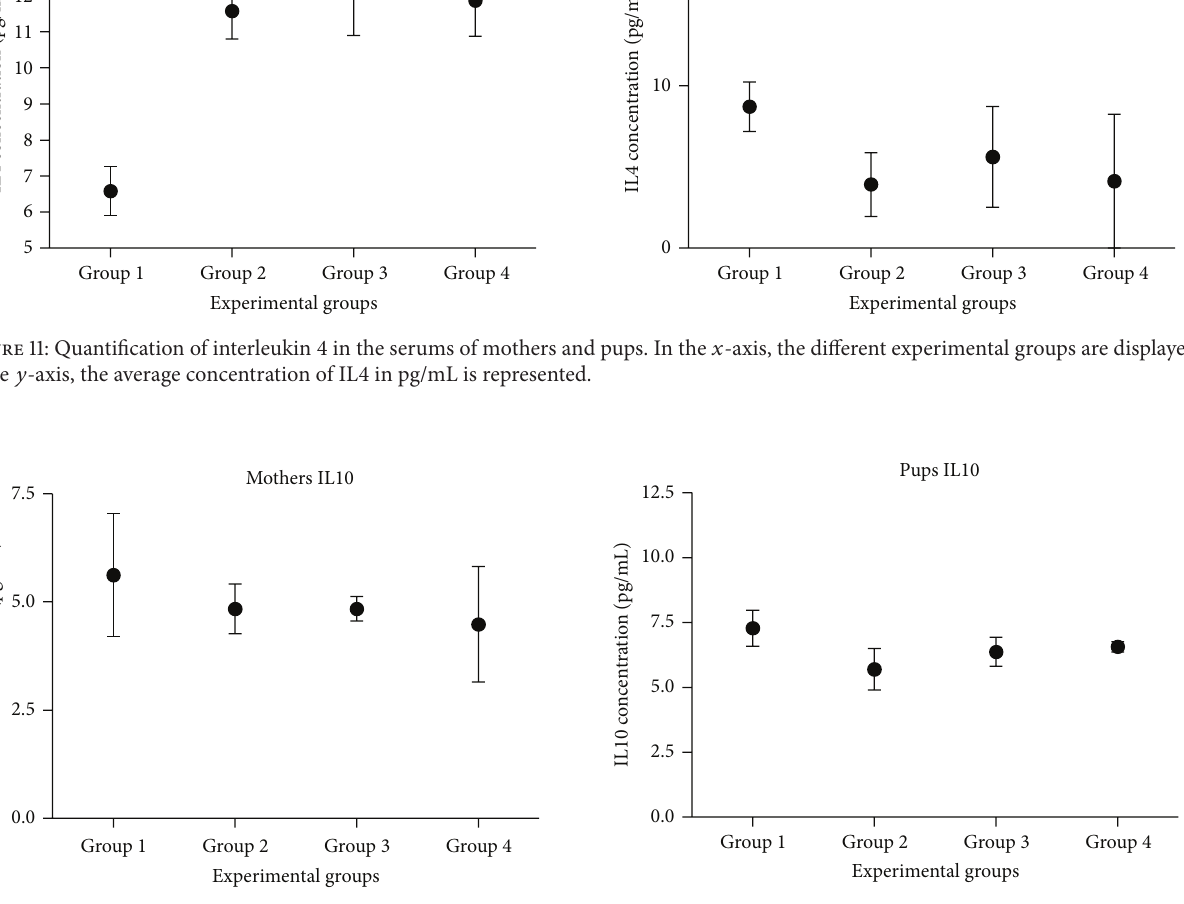
Figure 12: Quantification of interleukin 10 in the serums of mothers and pups. In the 𝑥 -axis, the different experimental groups are displayed; in the 𝑦 -axis, the average concentration of IL10 in pg/mL is